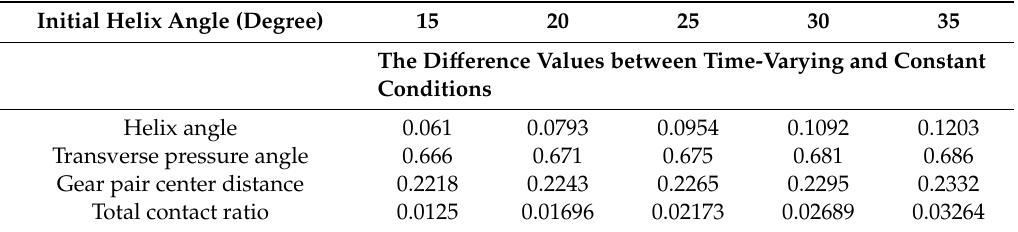
Table 5. The di ff erence values between the time-varying and the constant conditions.